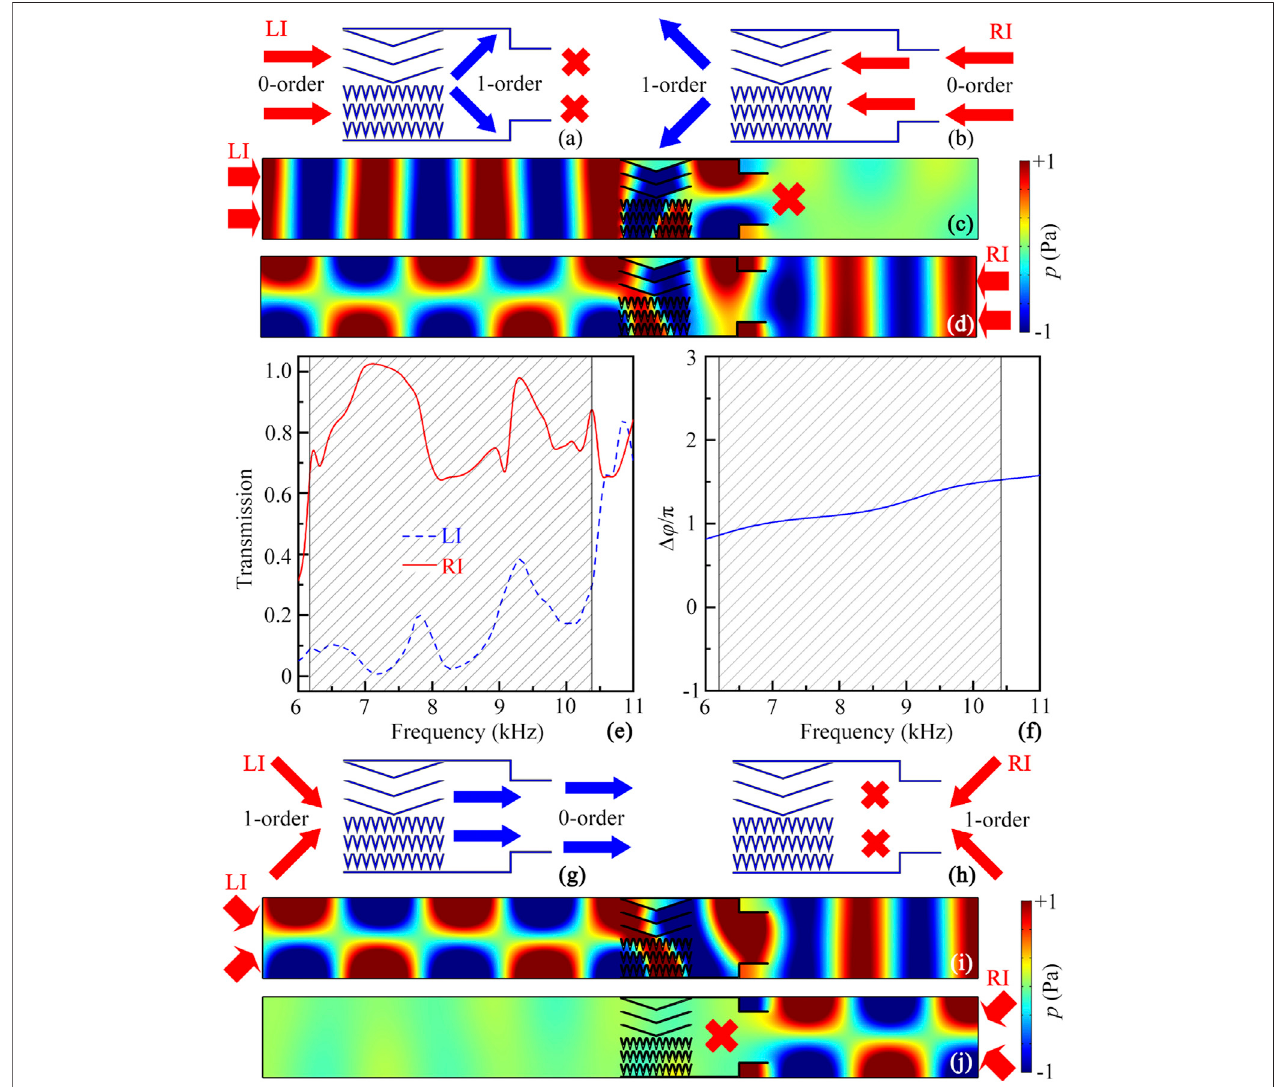
FIGURE 2 | Schematic of the propagation paths through the mode-conversion phased unit under the incidence of the zero-order wave for (A) LI and (B) RI. Simulated pressure distributions created by the phased unit under the incidence of the zero-order wave for (C) LI and (D) RI at 7.1 kHz. Red solid arrows in (A – D) represent the incident zero-order wave. (E) Simulated transmission spectra through the mode-conversion phased unit under the incidence of the zero-order wave for LI (blue dashed line) and RI (red solid line). (F) Simulated phase difference spectrum of both unit cells I and II. Black shaded region (6.2 – 10.4 kHz) represents the working band of the AAM. Schematic of propagation paths through the phased unit for the incidence of the fi rst-order wave for (G) LI and (H) RI. Simulated pressure distributions created by the phased unit under the incidence of the fi rst-order wave for (I) LI and (J) RI at 7.1 kHz. Red solid arrows in (G – J) represent the incident fi rst- order